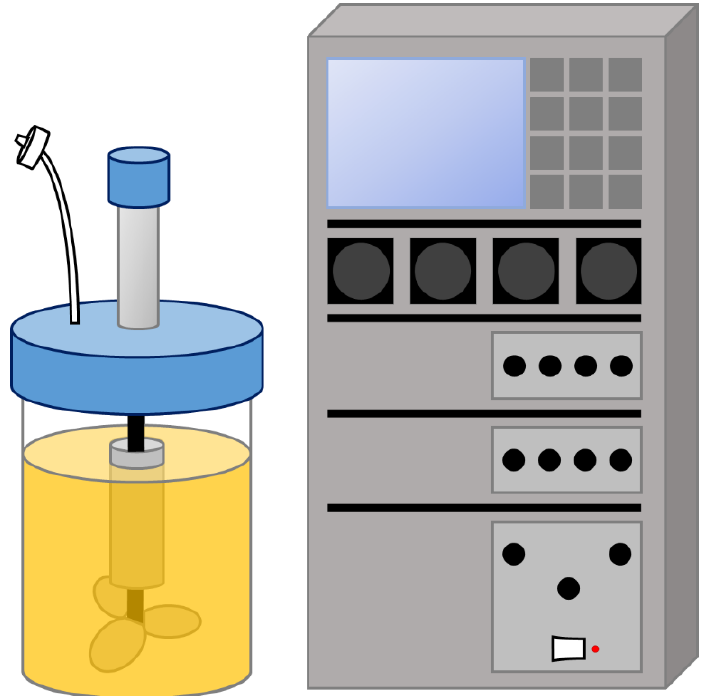
Figure 2. Schematics of a stirred-tank bioreactor vessel and controller unit. Table 2. Examples of single-use stirred-tank bioreactor systems with successful use for stem cell culture.